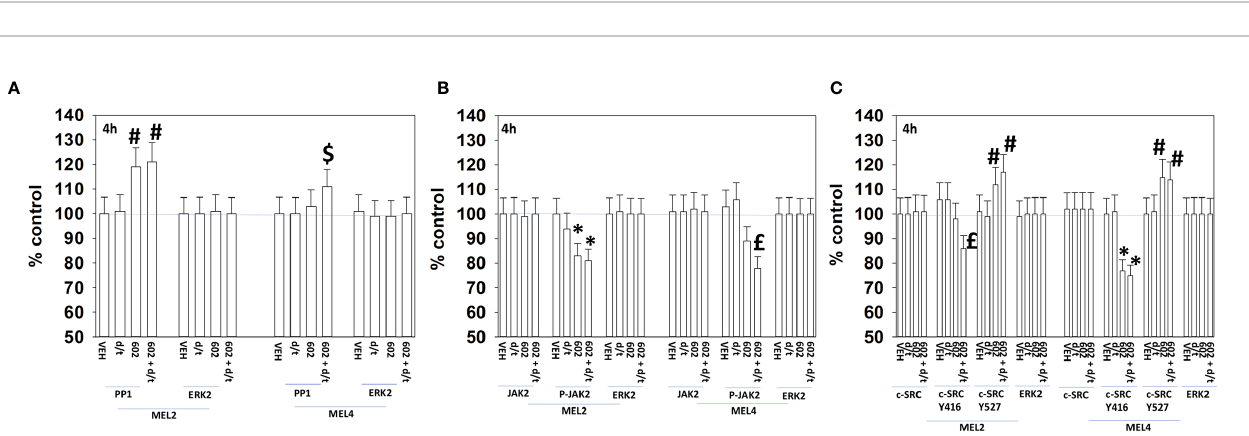
FIGURE 3 | GZ17-6.02 and [trametinib + dabrafenib] interact to inactivate ERK1/2 and p70 S6K. Melanoma cells were treated with vehicle control, GZ17-6.02 [curcumin (2 µM) + isovanillin (37.2 µM) + harmine (4.5 µM)], [trametinib (2 µM) + dabrafenib (2 µM)] or the drugs in combination for 4h. (the three bars per protein from left to right are trametinib/dabrafenib, GZ17-6.02 and the drugs combined). Cells were fi xed in place and in-cell immunostaining performed to determine the expression and the phosphorylation of the indicated proteins (n = 3 +/-SD) *p < 0.05 less than vehicle control; £ p < 0.05 less than either drug as a single agent; # p < 0.05 greater than vehicle control; $ p < 0.05 greater than either drug as a single